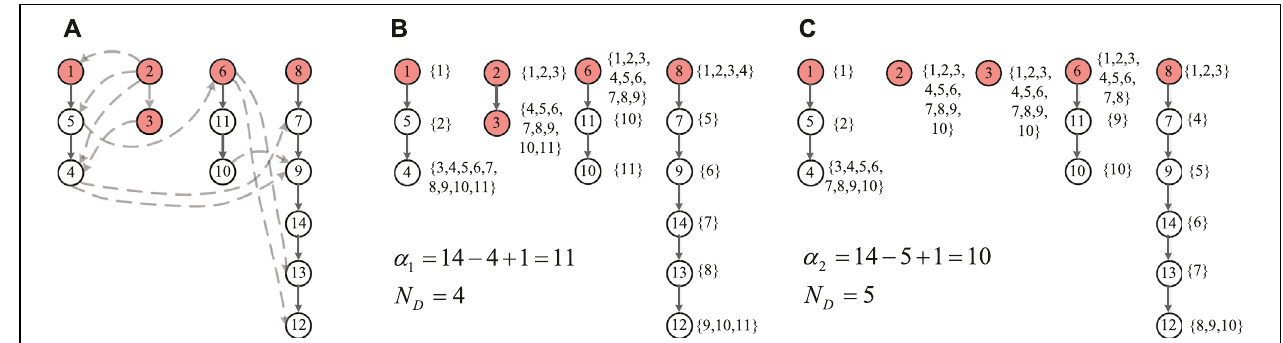
FIGURE 9 | (A) The forcing paths of four drive nodes in the IEEE 14 bus system. (B) The integer’s distribution on the forcing paths of four drive nodes in the IEEE 14 bus system. (C) The integer’s distribution on the forcing paths of five drive nodes in the IEEE 14 bus system.